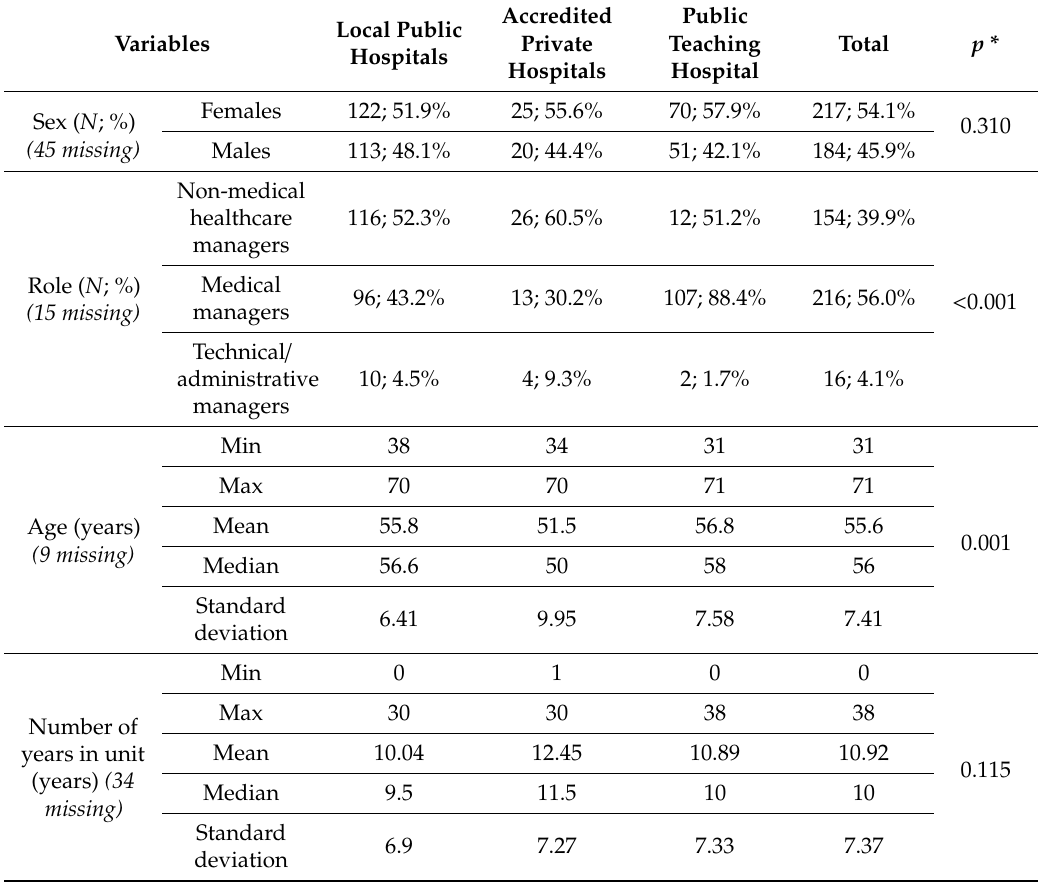
Table 2. Characteristics of the sample by type of